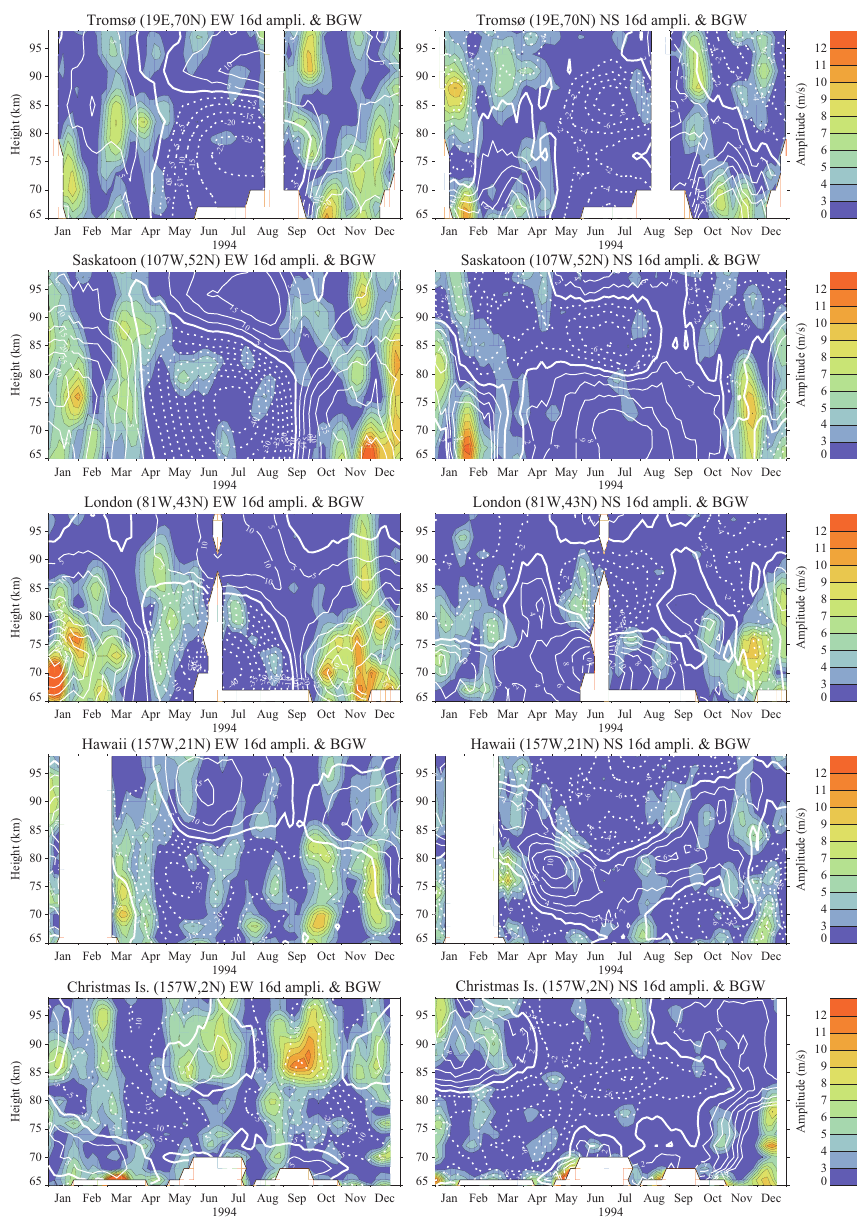
Fig. 5. The 16-day wave amplitudes plus the background winds in a height-time section of year 1994 at five radar locations. The zonal (EW) and meridional (NS) components of the wave and the mean winds (line contours) are displayed in the left and right columns, respectively. The mean wind contours step by 5 or 2m/s for the EW or NS winds, with solid lines denoting the eastward/northward directions, dashed lines the opposite directions, and thick ones the zero wind